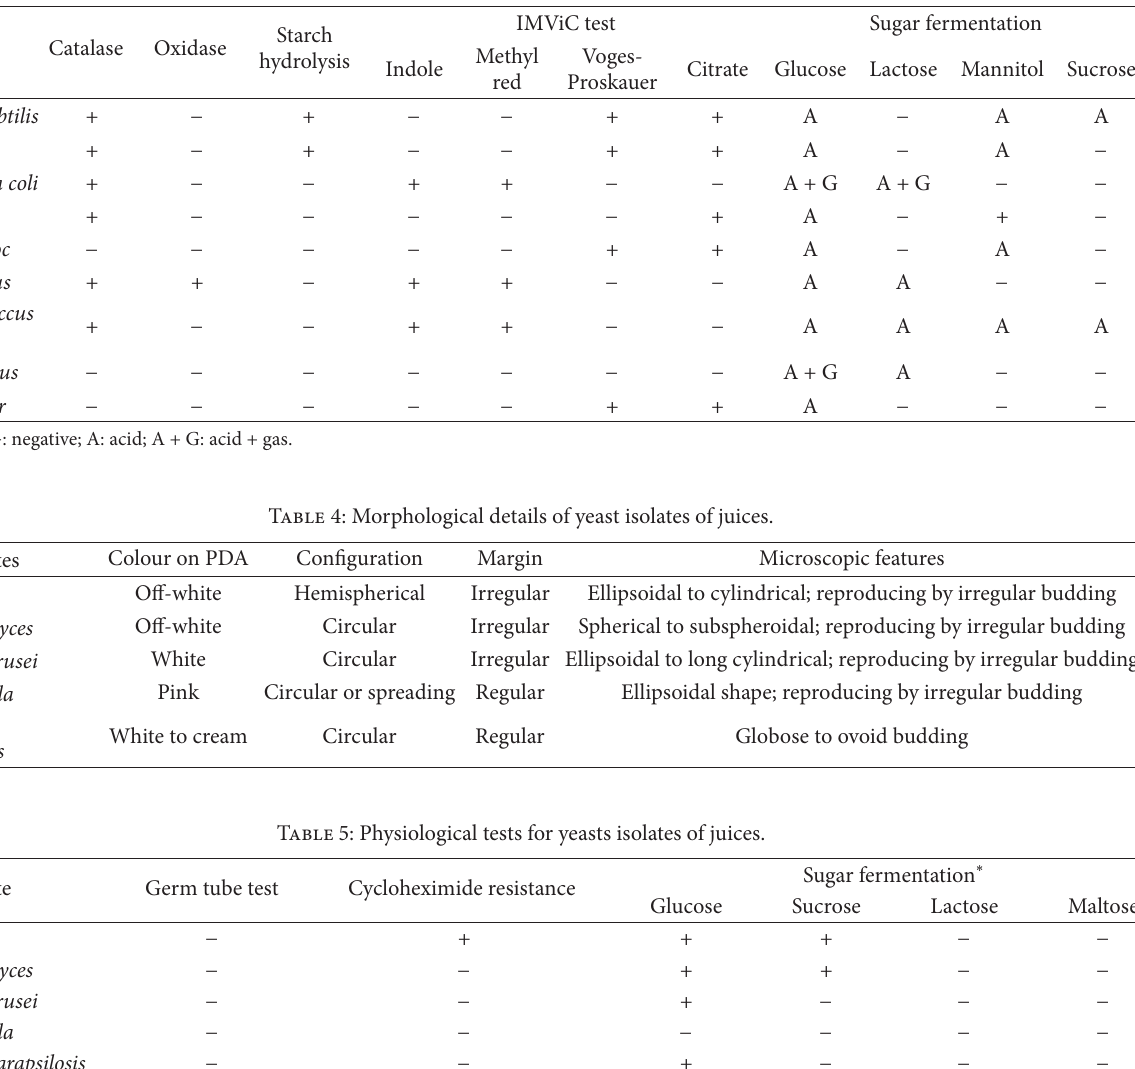
Table 3: Biochemical characteristics of bacterial isolates of juices.